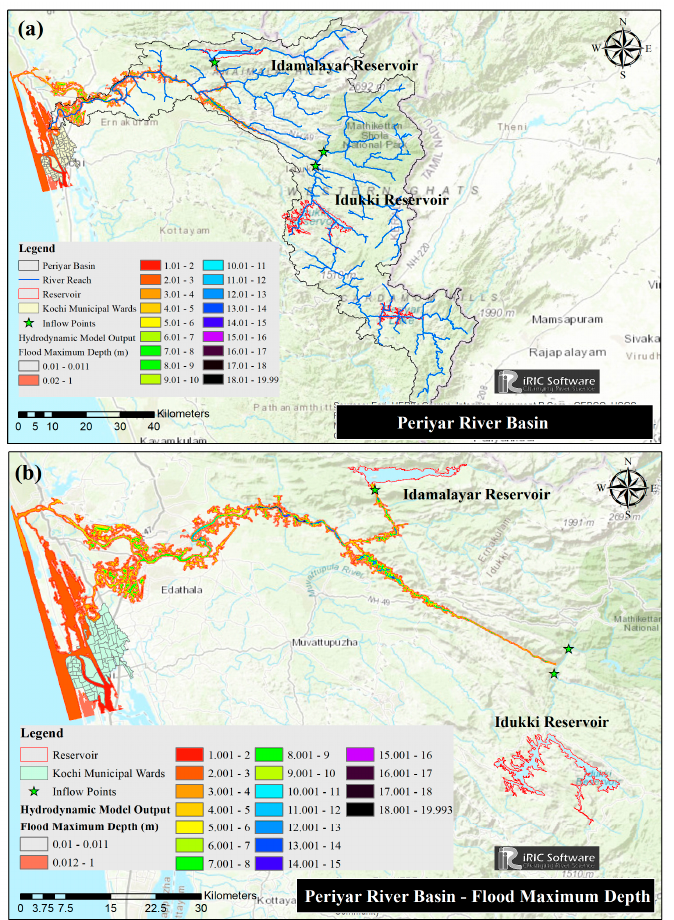
Figure 9. Hydrodynamic model flood depth output of Periyar river basin under controlled flow condition (with reservoir operation) where ( a ) shows the maximum flood depth in Periyar River Basin and ( b ) shows maximum flood water depth in the Periyar River basin.